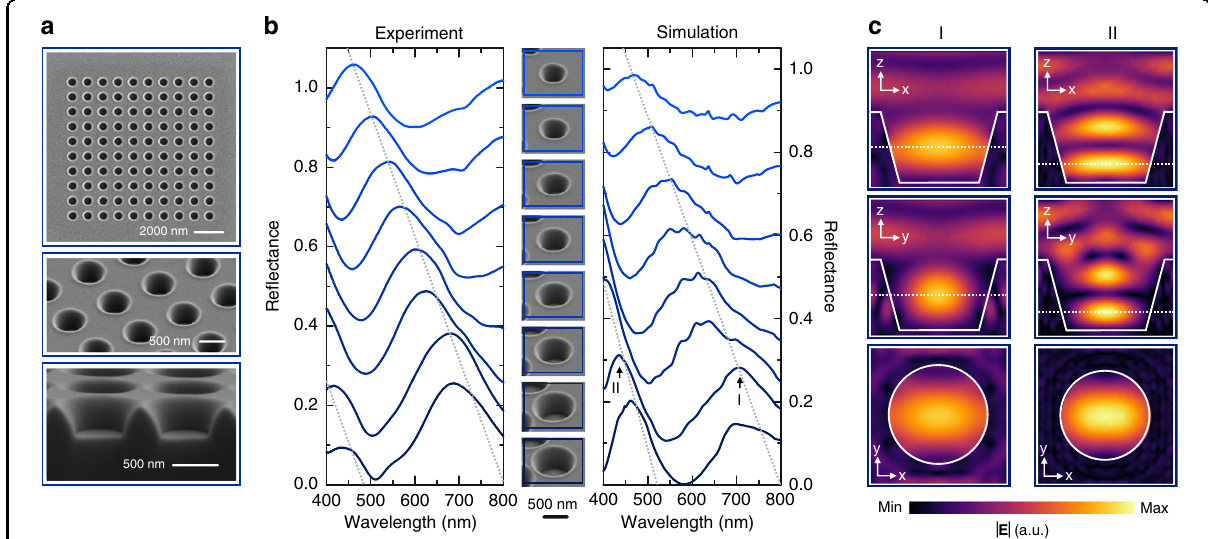
Fig. 3 Observation of Mie void modes. a SEM images of holes with a diameter of 610 nm and a depth of 410 nm arranged in a square grid of 900 nm periodicity in order to allow for spectroscopic measurement. The tilted view image of the same structures shows slightly inclined side walls, which are intrinsic to the milling process. The lowest image depicts a focused ion beam cut of holes with a 780 nm diameter viewed at a tilting angle of 80° underpinning the conical shape. b Experimental and simulated normal incidence re fl ectance spectra of Mie voids in the silicon substrate. With increasing diameter, the fundamental mode I red-shifts while a higher-order mode II emerges, undergoing a spectral red-shift with increase of the diameter as well. c Spatial distribution of the absolute value of the internal electric fi eld for light incident along the Z -axis and polarized along the X -axis for the second largest Mie void. The observed fi eld distributions at points I and II can be identi fi ed as the two fundamental modes predicted by Mie ’ s theory in Fig. 2, which are electric and magnetic-dipole modes, respectively (for details see Supplementary Fig.